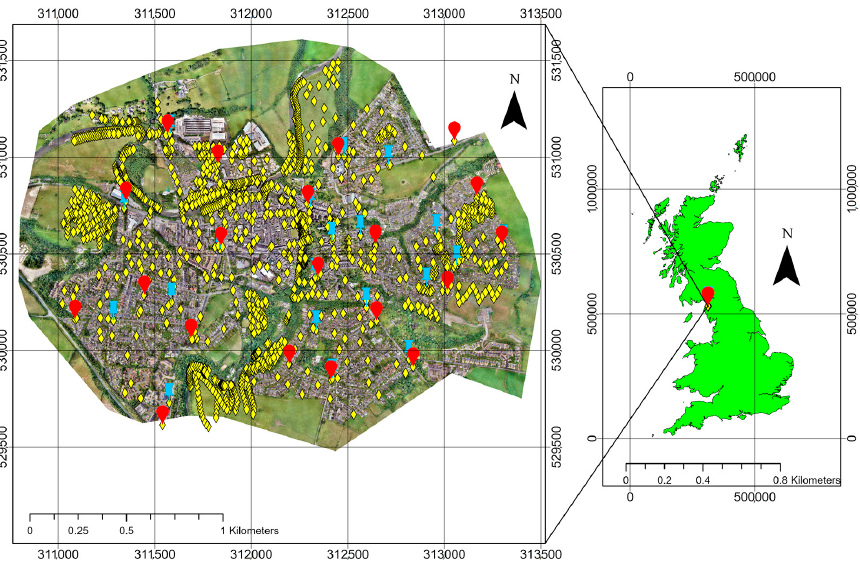
Figure 1. Study area at Cockermouth town, Cumbria, UK (surveyed area: 471 hectares). The red tear markers represent the 20 ground control points used for data collection purposes. The blue push pin markers represent check points (20), whereas the yellow diamond markers represent 2031 additional ground points considered in this study.